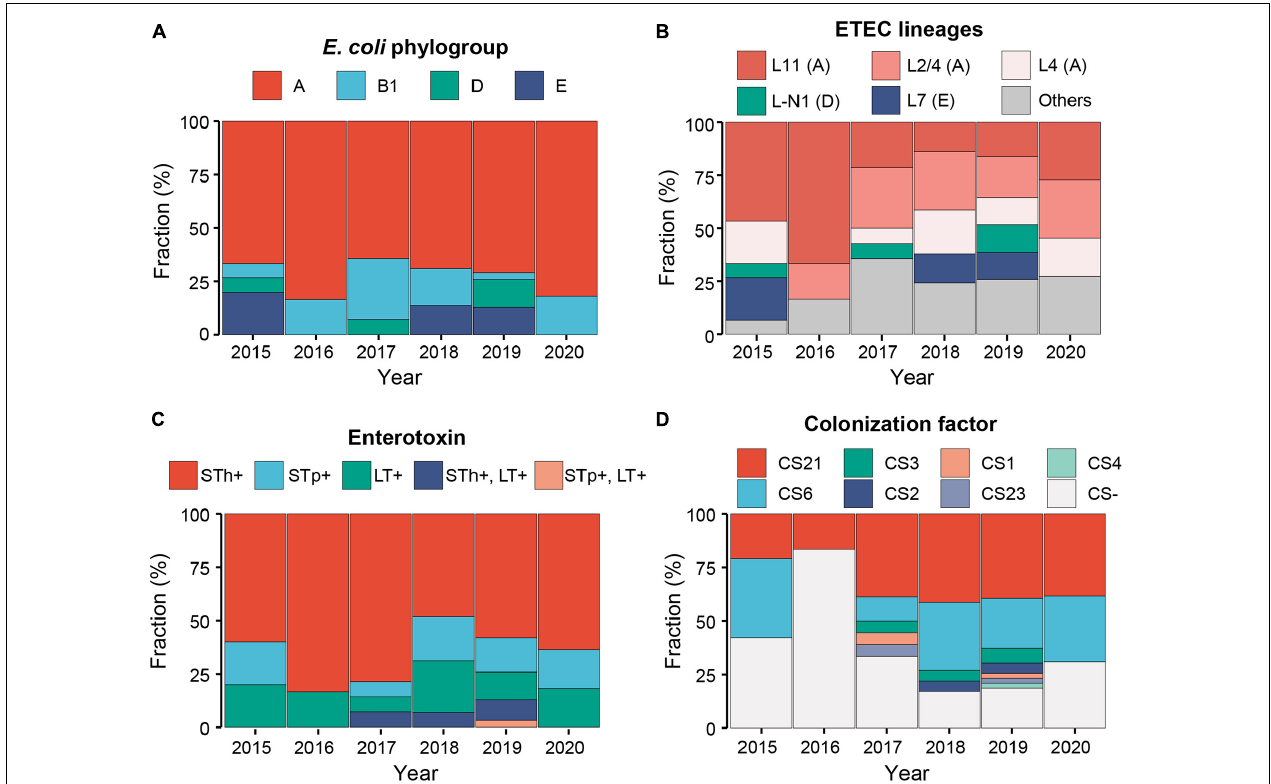
FIGURE 2 | Temporal dynamics of the E. coli phylogroups (A) , ETEC lineages (B) , enterotoxins (C) , and colonization factors (D) of Shenzhen isolates during the 6-year sampling period. Colors indicated different classifications as shown in the legends